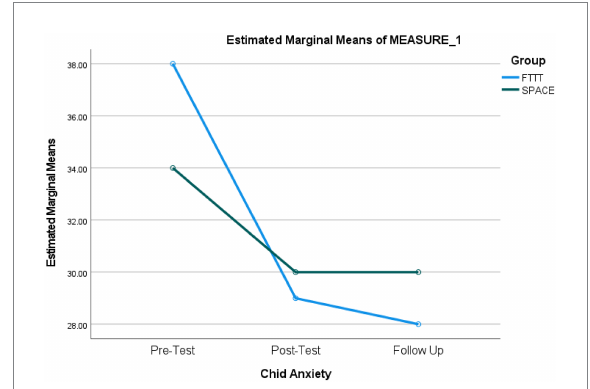
FIGURE 2 Repeated-measures ANOVA revealing significant changes from baseline to follow-up in child anxiety